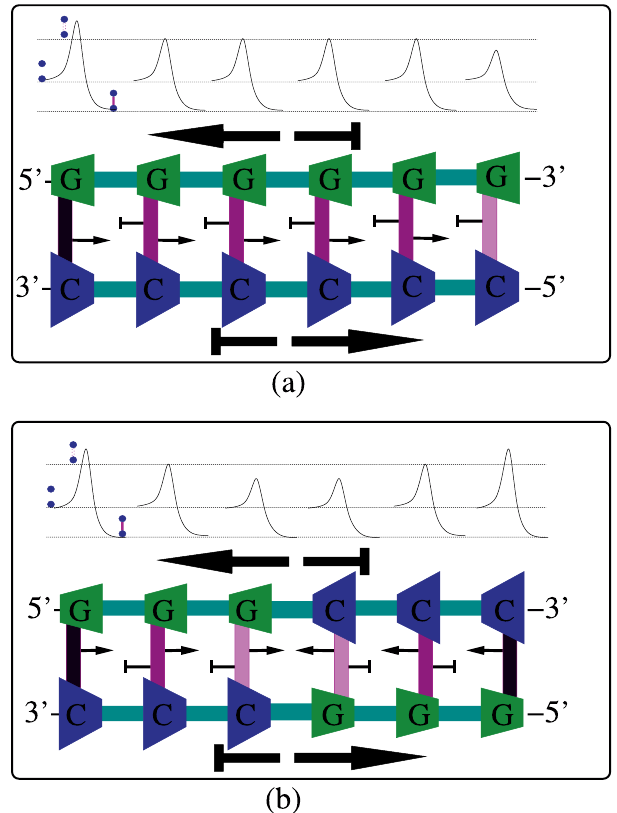
Figure 3. Illustration of sequence-dependent asymmetric cooperativity. In a DNA double strand, the anti- parallel orientations of the two strands result in the cancellation of their respective opposing asymmetric cooperativity modes. If the nucleotides on both the strands are of the same type, the cancellation would be complete, due to symmetry. When the types of nucleotides on the two strands are different, say, with C on the 3 ′ –5 ′ strand and G on the 5 ′ –3 ′ , the cancellation is not complete and the residual asymmetric cooperativity is dictated by the types of nucleotides, making the asymmetric cooperativity sequence-dependent. The thick arrows denote the sequence-independent asymmetric cooperativity dictated by the individual strands’ directionality, whereas the thinner arrows attached to the hydrogen bonds denote the sequence-dependent asymmetric cooperativity that changes its mode depending on the orientation of the base-pair. 5 ′ – G –3 ′ /3 ′ – C –5 ′ base-pair orientation of the hydrogen bonds instantiates right asymmetric cooperativity, as shown in ( a ), whereas the 180° -rotated 5 ′ – C –3 ′ /3 ′ – G –5 ′ instantiates left asymmetric cooperativity, as the last three bonds of ( b ) illustrates. The kinetic barrier diagrams above the strands in ( a , b ) are significantly different, illustrating the sequence-dependence of the unzipping behavior of DNA double strands. The color of the hydrogen bonds represent the height of the kinetic barrier separating bonded and unbonded configurations, higher the barrier, darker the color. The unzipping of the strand in ( a ) would proceed sequentially from the rightmost end, whereas the middle two bonds would break and the strand will simultaneously unzip in both the directions in ( b ). This is proposed to lead to simultaneous construction of daughter strand on multiple segments of the single strand template in anti-parallel